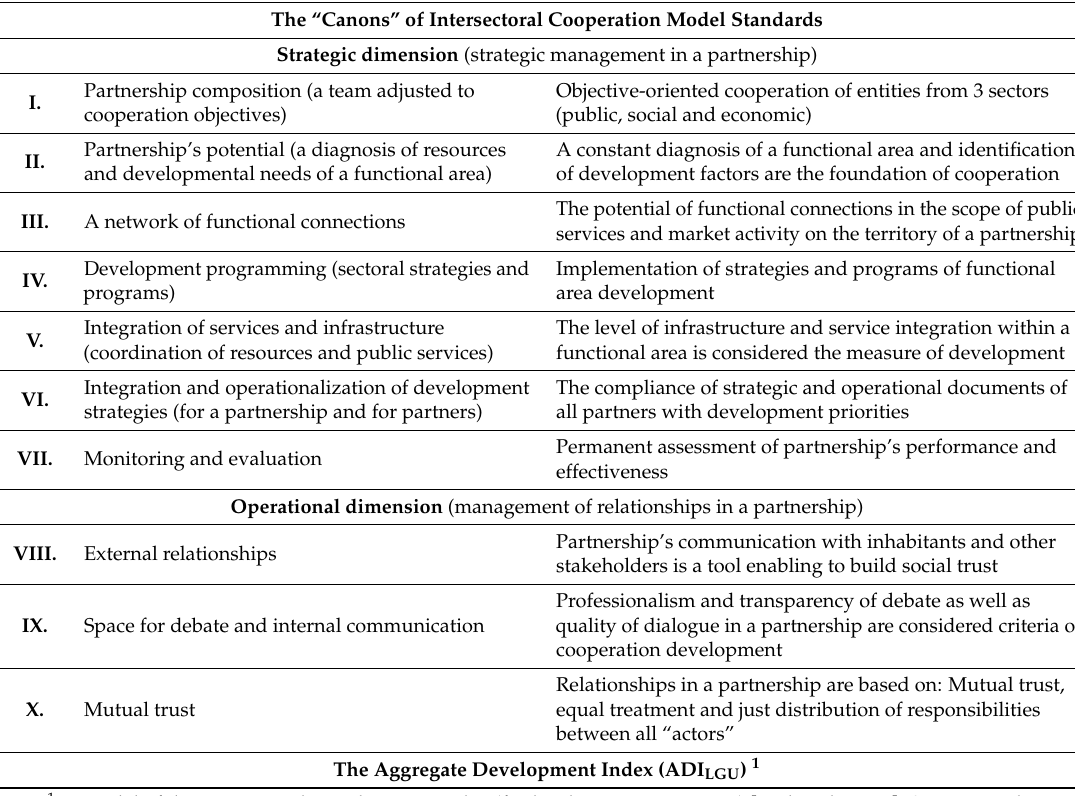
Table 2. The 10 areas determined by the “canons” of intersectoral cooperation model